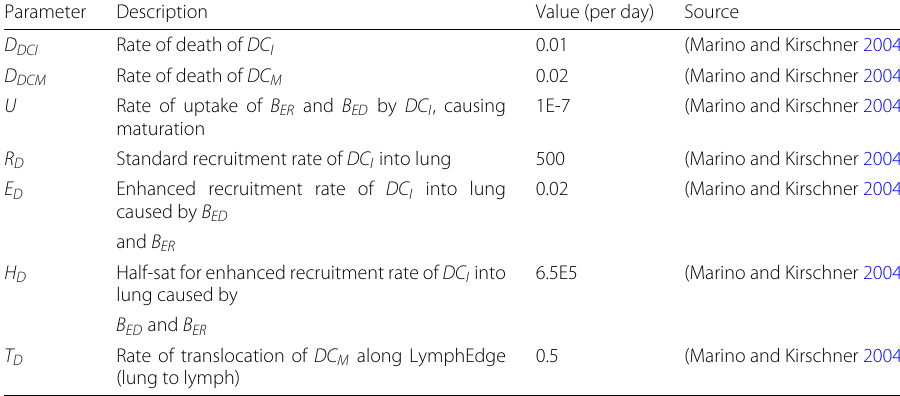
Table 4 Dendritic cell event parameters used for experiments, unless specified in the text Parameter Description